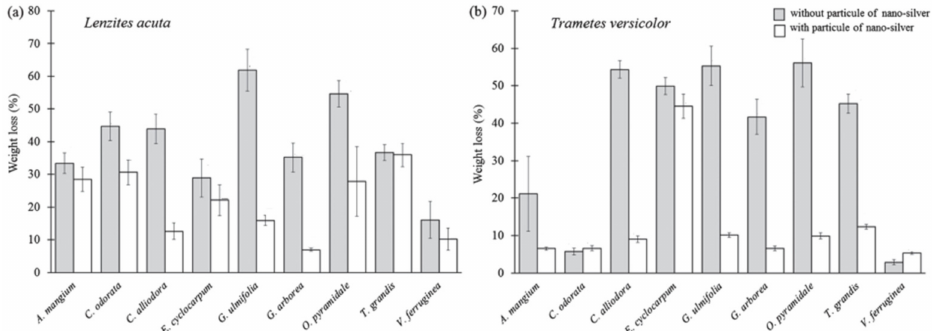
Figure 12. Relative weight loss in the wood samples with and without AgNPs treatment, for the diseases caused by the fungus Lenzites acuta ( a ) and Trametes versicolor ( b ), for several different types of wood. Image retrieved from